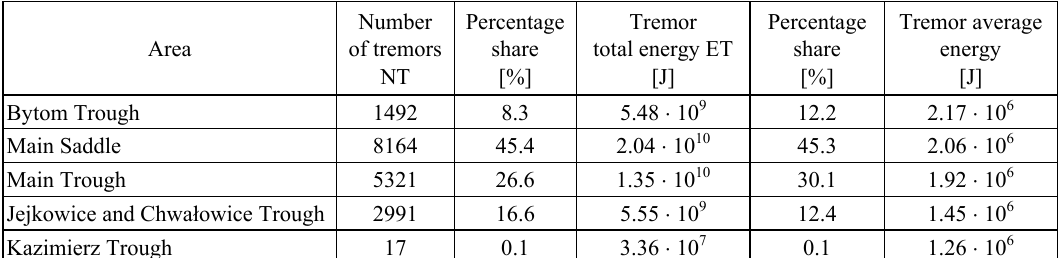
Table 1. List of tremors between 2001 and 2015 in the structural units of